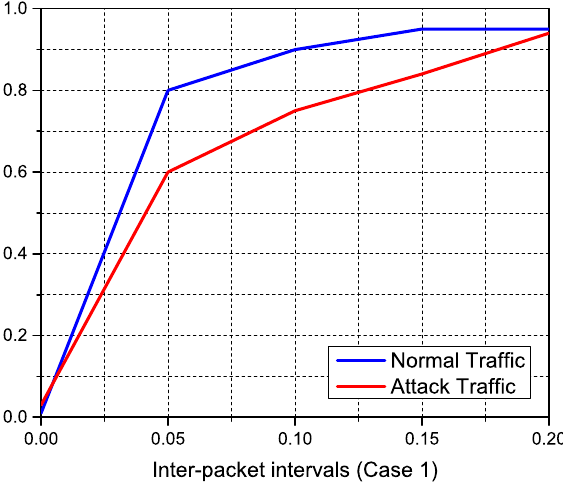
Figure 20. The inter-packet intervals of ∆ T are used to detect DDoS anomalies in IoT